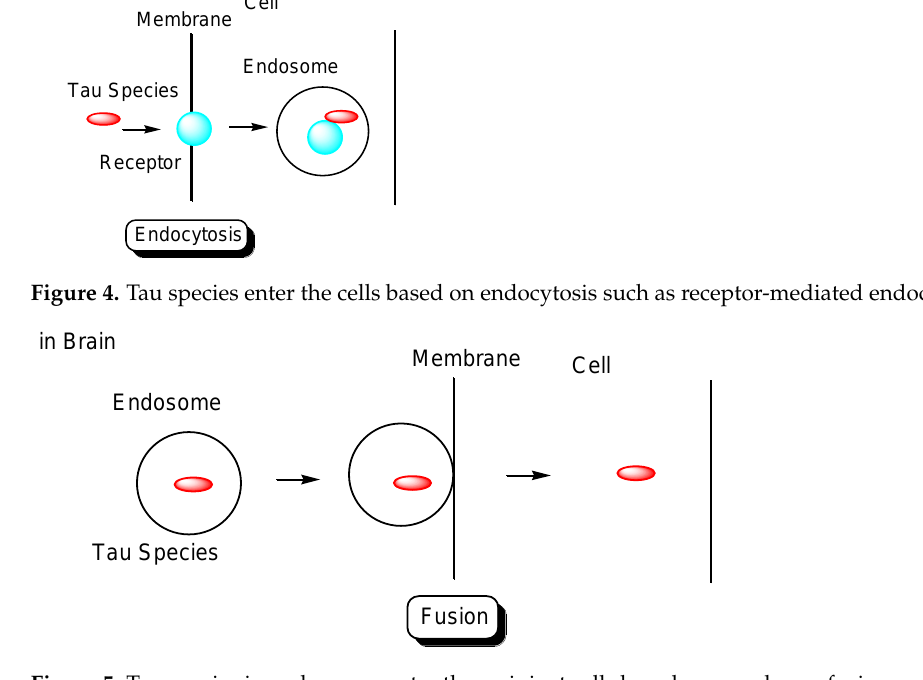
Figure 5. Tau species in endosomes enter the recipient cells based on membrane fusion. Second, Alexa Fluor TM -labeled tau oligomers derived from AD and DLB brains were transported into cortical neurons isolated from C57BL/6 mice through heparan sulfate proteoglycan (HSPG)-induced, clathrin- and caveolae-independent endocytosis, and remained in endosomes from early endosomes to lysosomes. In contrast, labeled tau oligomers derived from PSP brains were transported through other pathways [30]. Positively charged CPPs, short amino acid oligomers (5–30 residues), such as TAT and R8,